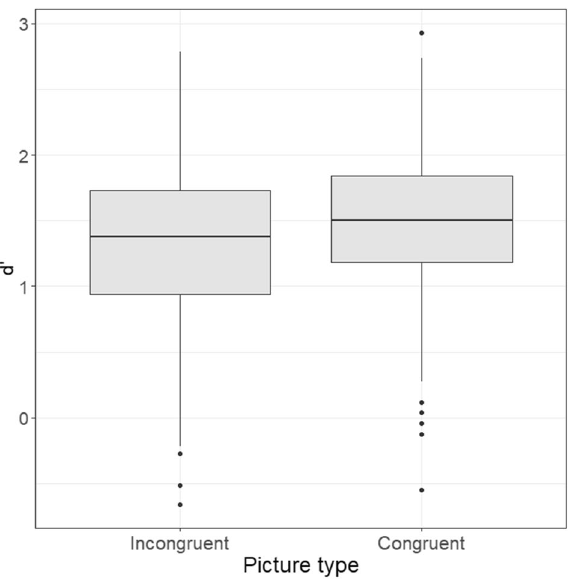
Figure 2. Boxplots representing recognition-accuracy ( d ′ ) for congruent and incongruent pictures. The horizontal line inside the box represents the median. The dots represent the outliers.